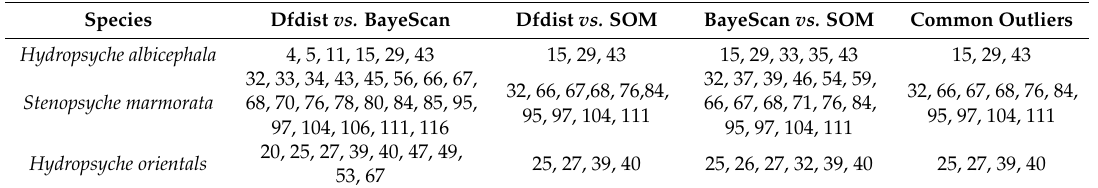
Table A1. List of outlier loci identified by Dfdist, BayeScan, and SOM.